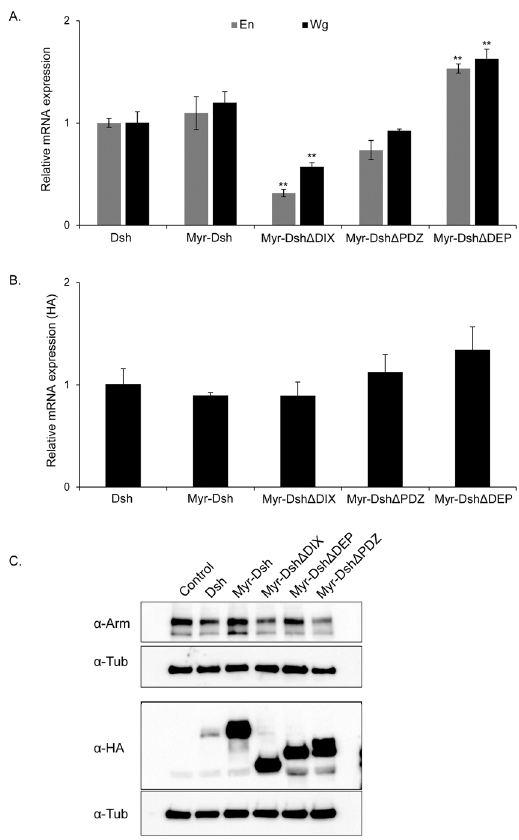
Figure 7. ( A ) Comparison of gene expression levels of wg & en in embryos expressing the indicated Dsh constructs. Reduced wg and en expression levels were observed in Myr-Dsh Δ DIX expressing embryos compared to control embryos and embryos expressing Dsh. * p < 0.05 , ** p < 0.01 relative to control. ( B ) Gene expression levels of HA Tag in embryos expressing the respective Dsh constructs. Significantly elevated expression of HA was detected in all transgenic lines compared to control. ** p < 0.01 . ( C ) Western blot comparing total Arm protein levels in embryos expressing the various HA tagged myristoylated Dsh